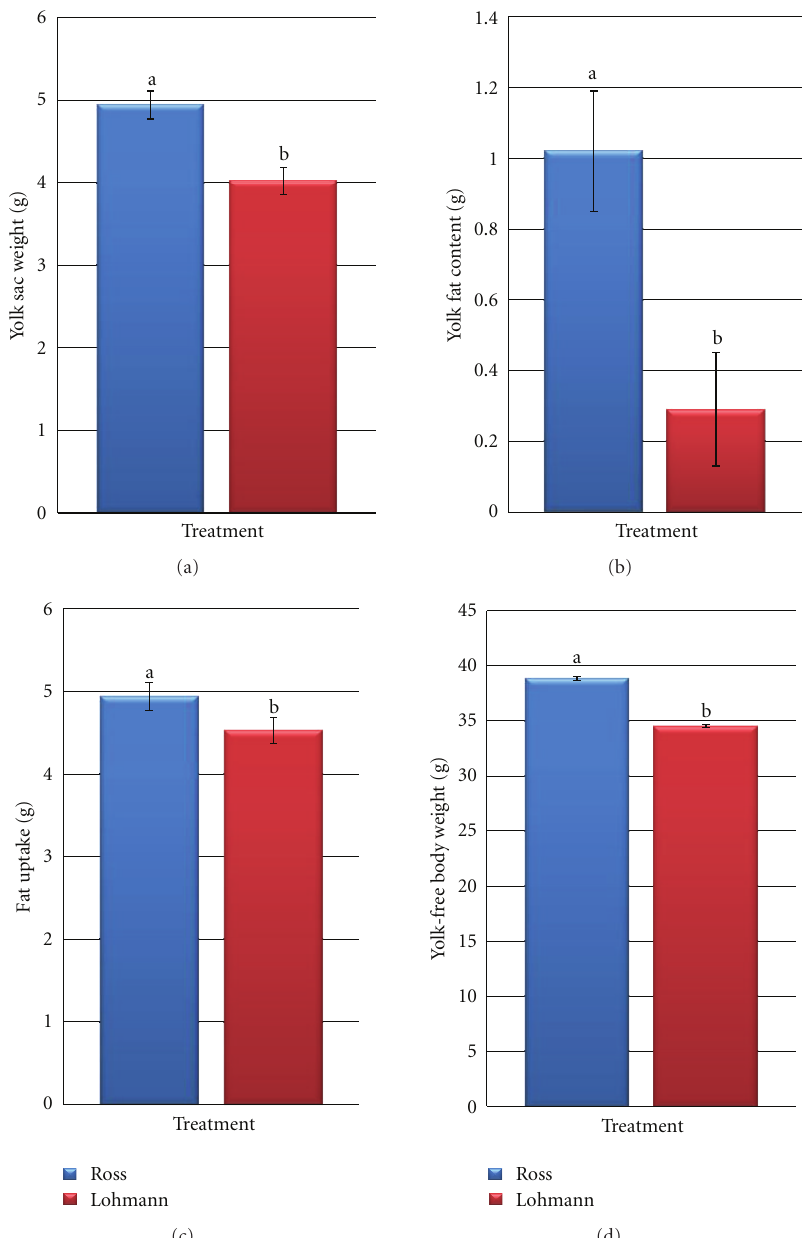
Figure 2: Comparison of (a) yolk sac weight (YS), (b) yolk fat content (YF), (c) fat uptake (FU), and (d) yolk-free body weight (YFBW) of Ross (broiler-type) and Lohmann (layer-type) hatchlings in ovo injected with di ff erent concentrations of AgNano (50, 75, and 100 mg/kg) and the control (no injection) at 24 h after hatching. Mean values and standard errors of 4 treatments, each containing 10 chicks. a,b Significant di ff erence ( P < 0 . 05) between